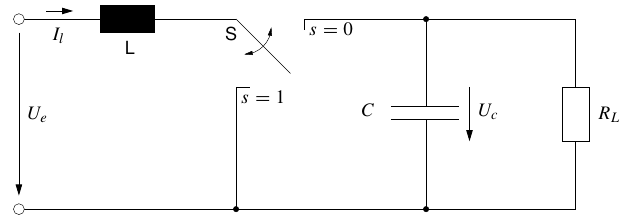
Figure 2. Lossless boost converter with resistive load.